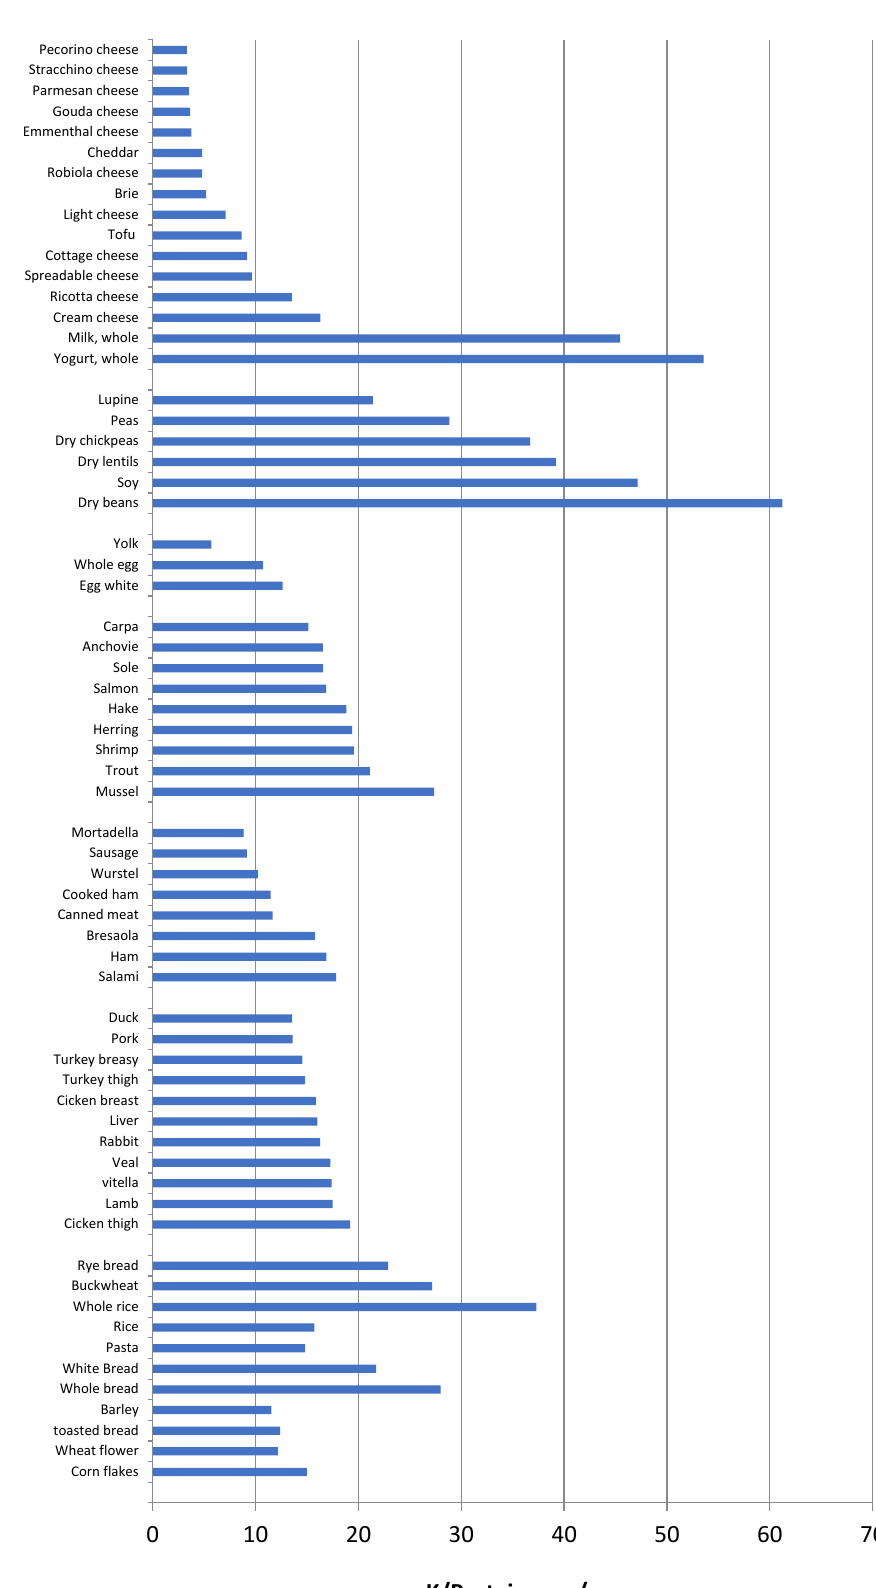
Figure 2. Potassium to protein ratio (mg/g) in several food categories.